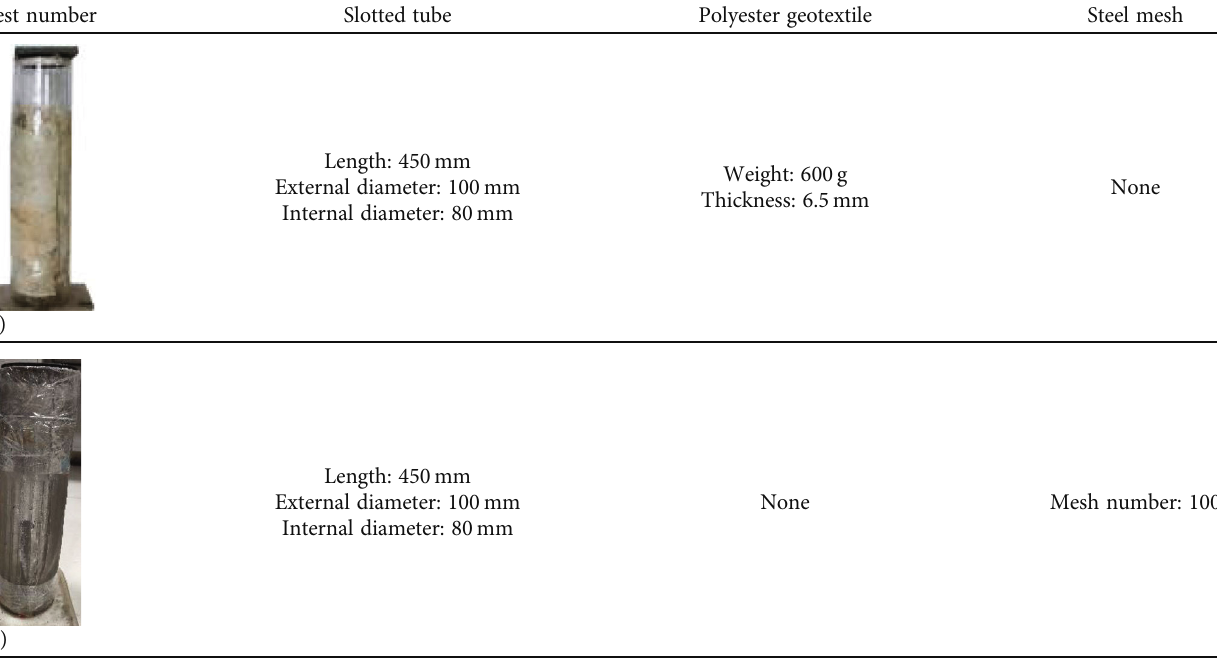
Table 1: Test details.